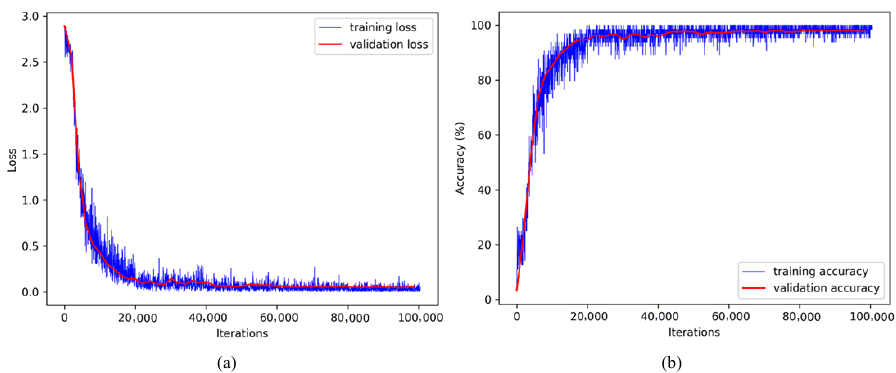
Figure 7. Convergence curves of the proposed modified VGG network. ( a ) Loss vs. iterations and ( b ) accuracy vs. iterations.